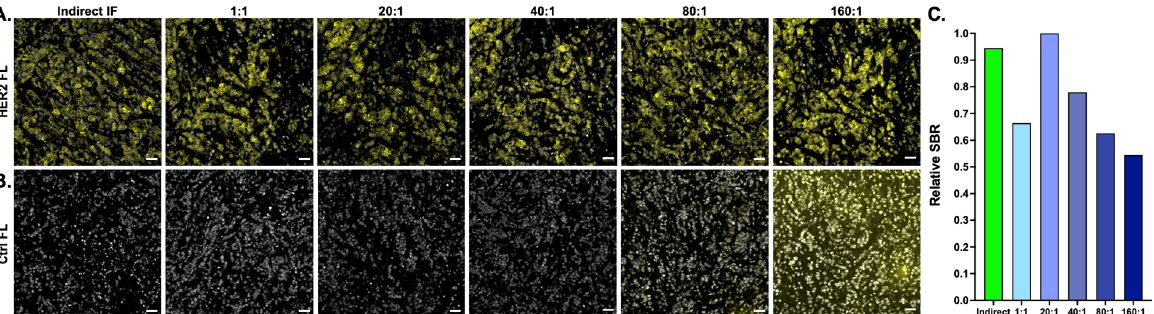
Figure 2. Ab-oligo amplification molar ratio titration. ( A ) MCF7-HER2 xenograft FFPE tissue sections were stained with either a HER2 primary antibody for indirect IF or a HER2 Ab-oligo conjugate (HER2 = yellow and DAPI = white), where a titration of molar excess of Amp IS to AmpS was performed from 1:1–160:1. ( B ) Negative controls for each sample were stained with only fluorophore-labeled secondary antibodies or the respective concentrations of AmpS and Amp IS without an Ab-oligo conjugate. ( C ) Image quantification was performed to calculate the relative signal- to-background ratio (SBR) for all staining conditions. Images shown are representative of multiple fields of view and quantification results are reported as a representative average. Scale bar = 50 µ